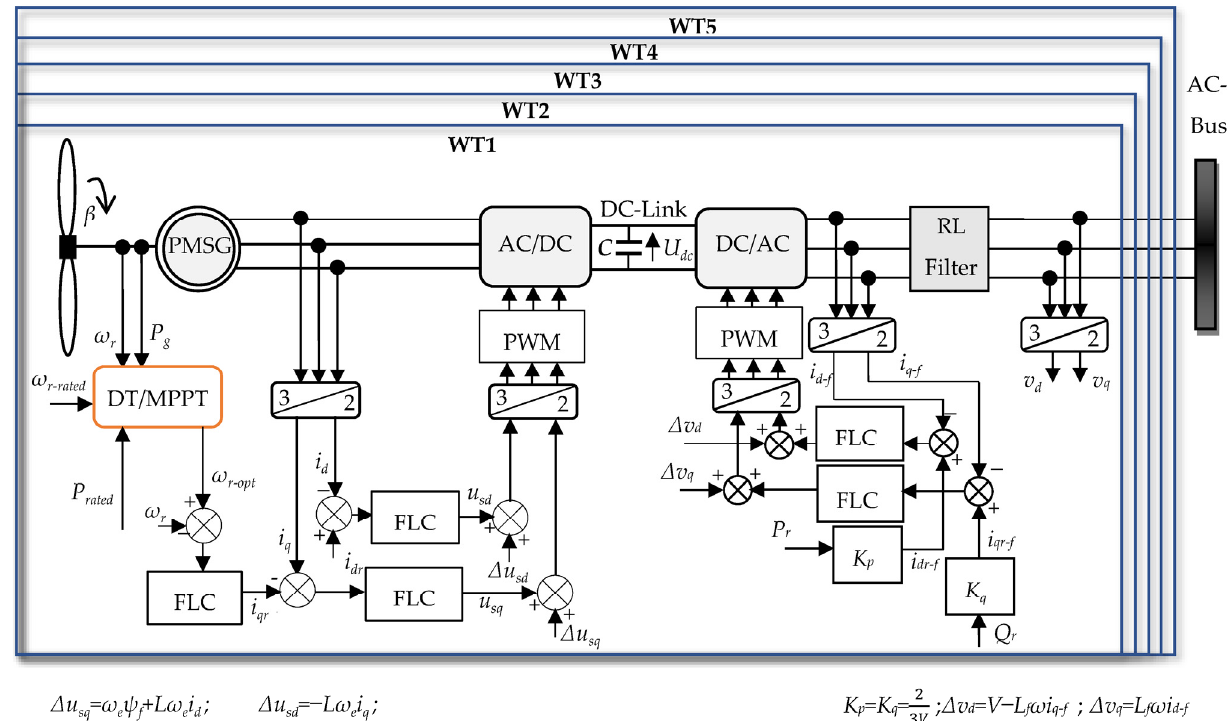
Figure 3. The global scheme of the wind-farm-based five PMSG configuration [14–16].